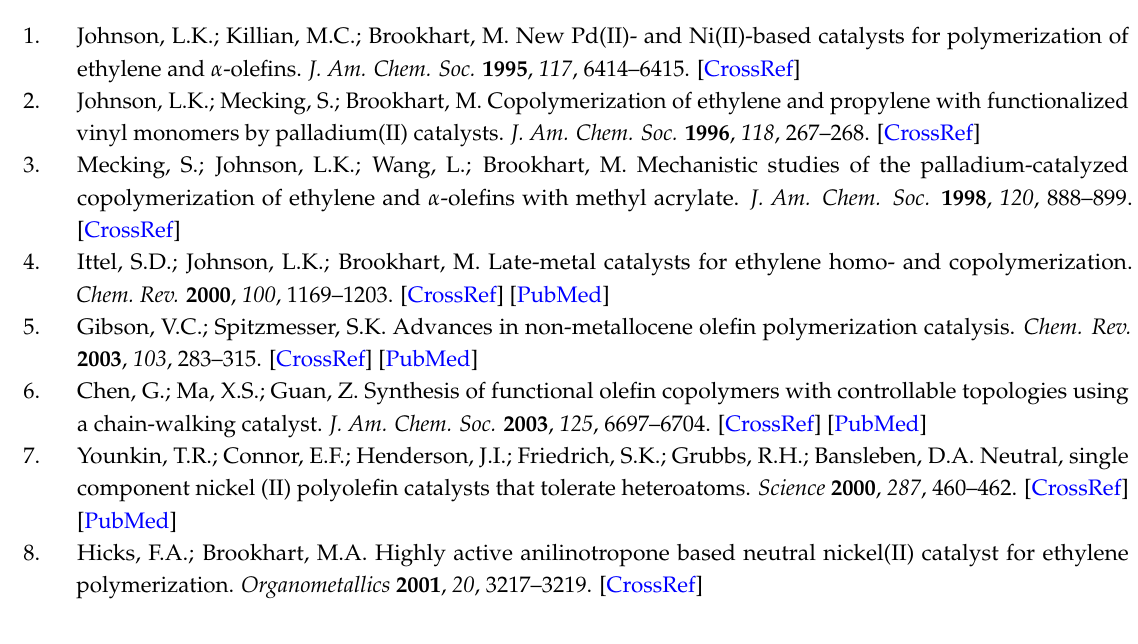
Table S1: The catalytic activities for complexes 1 – 20 at different temperatures along with the reaction time, Table S2: The bond lengths and bond angles for metal atoms and atoms coordinated with central metal, which were used as parameters of modified Dreiding force field, Table S3: The correlation coefficient ( R 2 ) results for the models of Fe and Ni-based complexes that were fitted by one, two and three parameters,